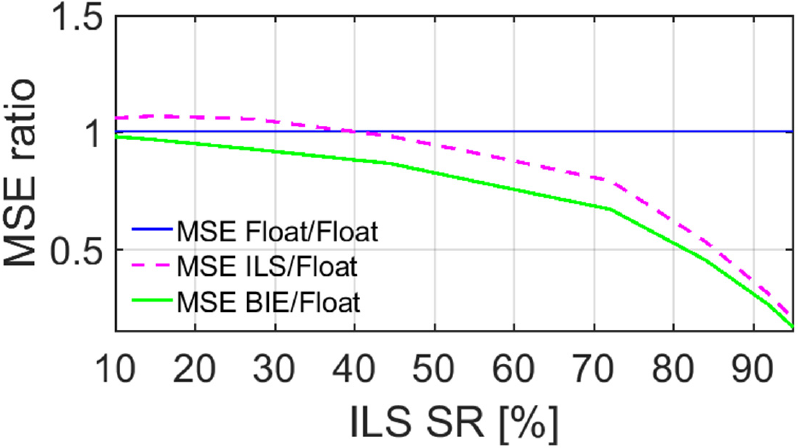
Figure 6. MSE ratios of the GP4 dual-frequency, short-baseline, and instantaneous RTK positioning errors using internal antennas, with BIE (green line), ILS (dashed magenta line), and ambiguity float (blue line), all versus the float solutions. Table 3. Empirical STDs of the ILS, BIE, and float solutions for dual-frequency and instantaneous RTK using GP4 smartphones, based on 6 h observations for a short-baseline internal antenna exper- iment (see Figure 4). Comparisons of the percentage of the 3D position errors within a range of 0.05 m, 1.0 m, 2.0 m, and 4.0 m are also given. Bold values show the largest percentages for each scenario and estimator.